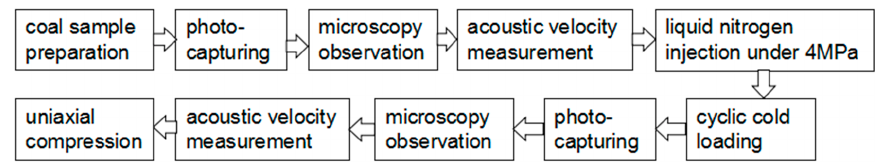
Figure 2. Flow chart of experiments.